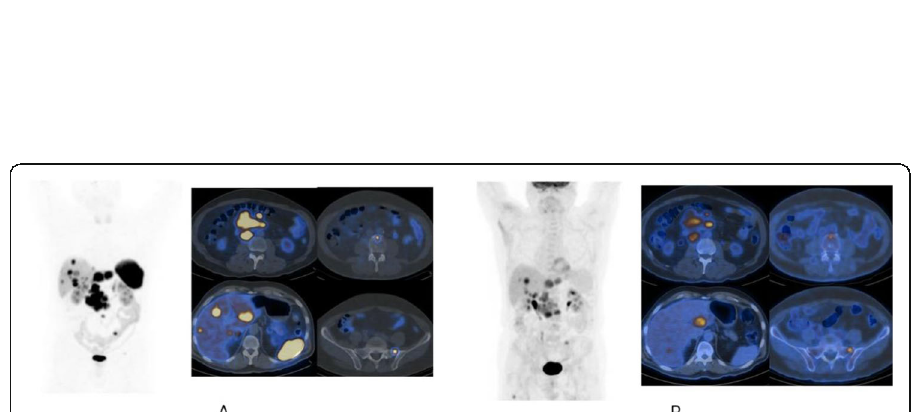
Fig. 53 68 Ga-DOTA peptide, staging NET of the pancreas, comparison with FDG. Clinical history : 68 y.o. man with moderately differentiated multi-metastatic NET of pancreas (Ki67 8%). PET/CT findings : 68 Ga-DOTANOC PET/CT shows intense pathologic uptake of somatostatin receptor analogue by the known pancreatic tumour, as well as in lymph nodes, multiple liver lesions, and previously unknown bone lesions ( a ). FDG- PET/CT confirms pathologic uptake of the tracer in pancreas and lymph nodes and in some of the known liver and bone lesions ( b